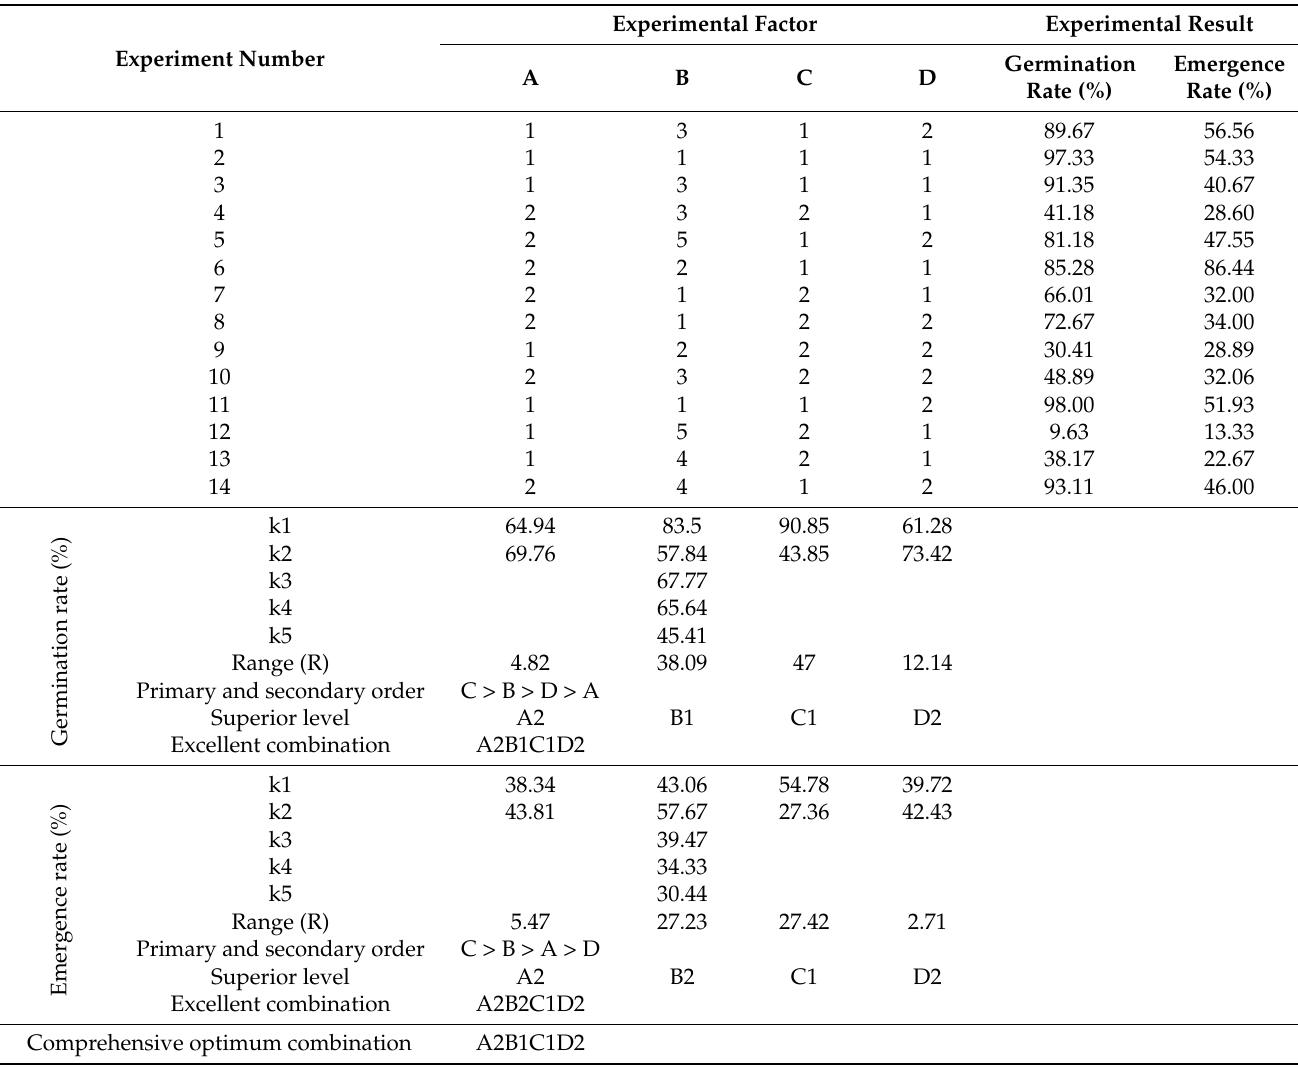
Table 6. Orthogonal experimental design and optimum results of Cabernet Sauvignon grape seeds. Experimental Experiment Number